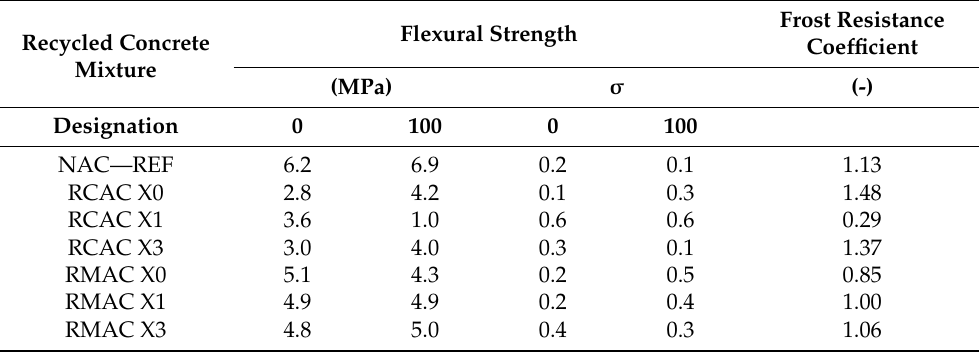
Table 7. Flexural strength and frost resistance coefficient determined from flexural strength after freezing and thawing